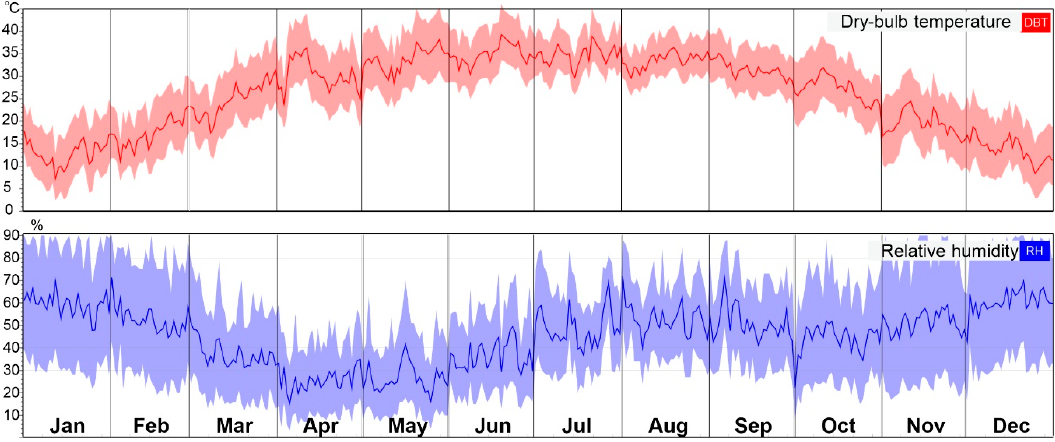
Figure 10. Temperature and relative humidity profile of test reference year for the climatic condition of Multan (Pakistan).